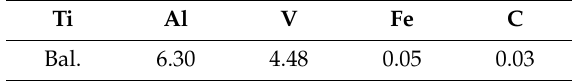
Table 1. Chemical composition of Ti-6Al-4V titanium alloy (wt.